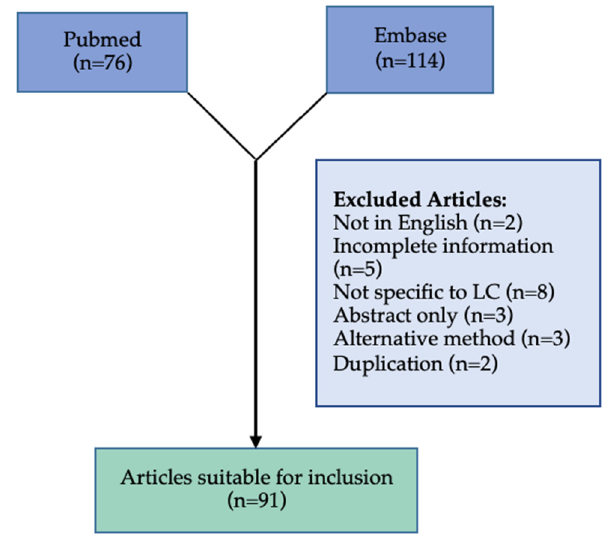
Figure 1. Flowchart of the systematic review process.